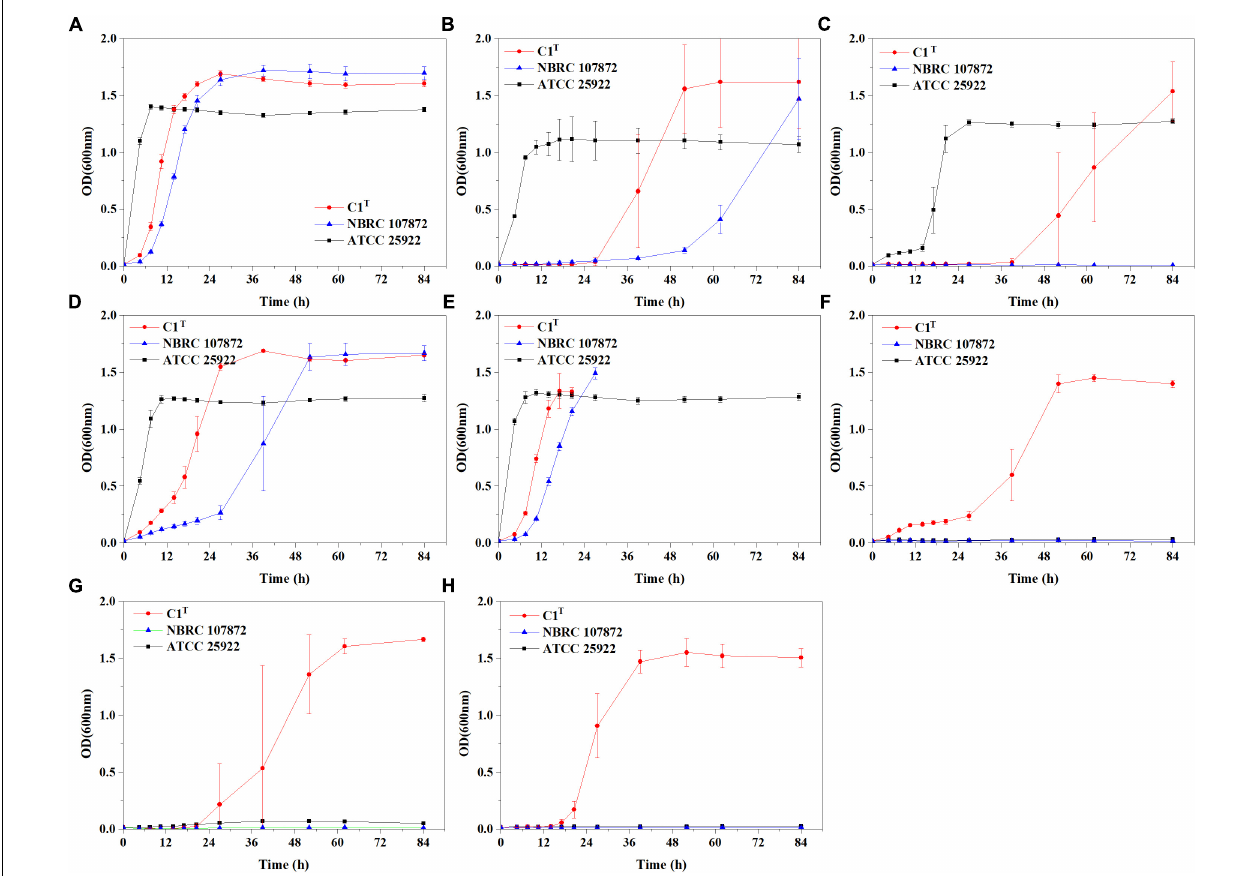
FIGURE 1 | Growth curves of strains C1 T , NBRC 107872 and ATCC 25922 in LB liquid medium with heavy metals. (A) Control group, with no heavy metal. (B) 3 mM Cu 2 + . (C) 0.3 mM Cr(VI). (D) 1.5 mM Ni 2 + . (E) 3 mM Pb 2 + . The cultures of strains C1 T and NBRC 107872 gradually became brownish black after OD 600 exceeded 1.5. (F) 1 mM Cd 2 + . (G) 0.25 mM Hg 2 + . (H) 6 mM Zn 2 + . The values are means of triplicate investigations, and error bars indicate standard deviations. The error bars are large in (B,C,G) due to obvious differences in lag phases among three replicates of strain C1 T